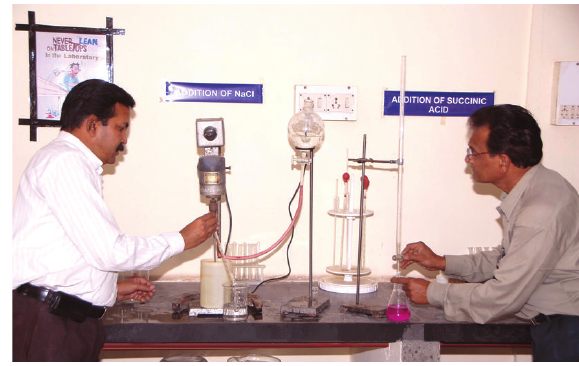
Figure 1: Continuous stirred tank reactor.